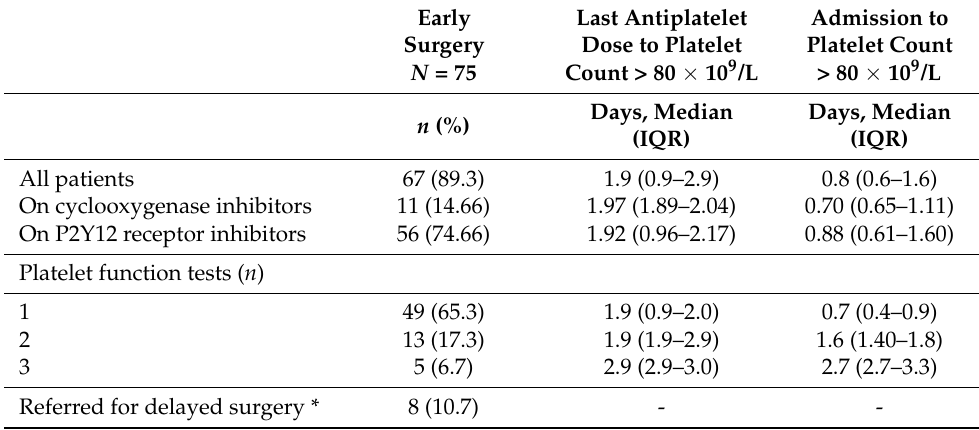
Table 2. Pre-surgery functional platelet tests for the experimental group.